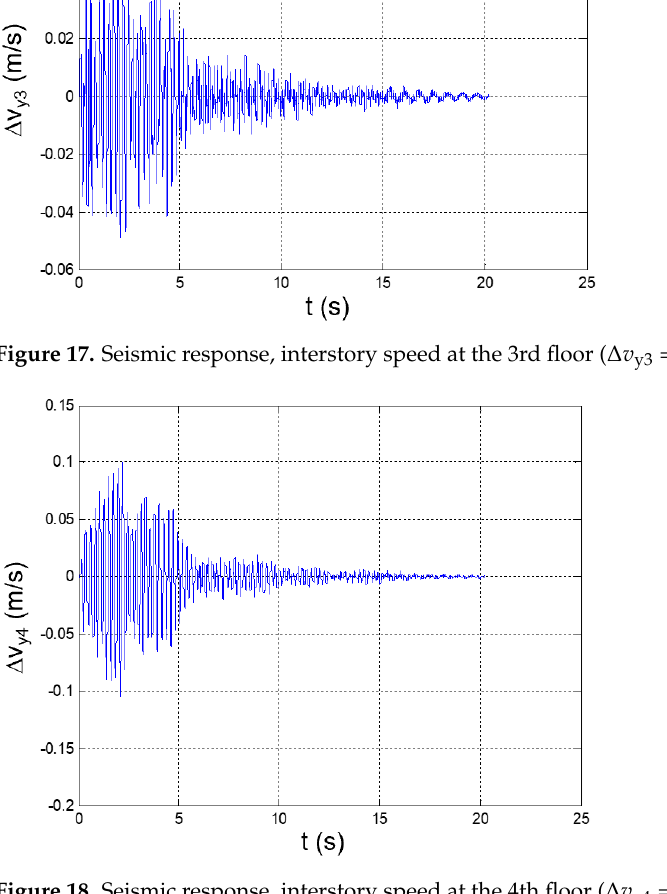
Figure 18. Seismic response, interstory speed at the 4th floor ( Δ 𝑣 y4 = 𝑣 y4 − 𝑣 y3 ).